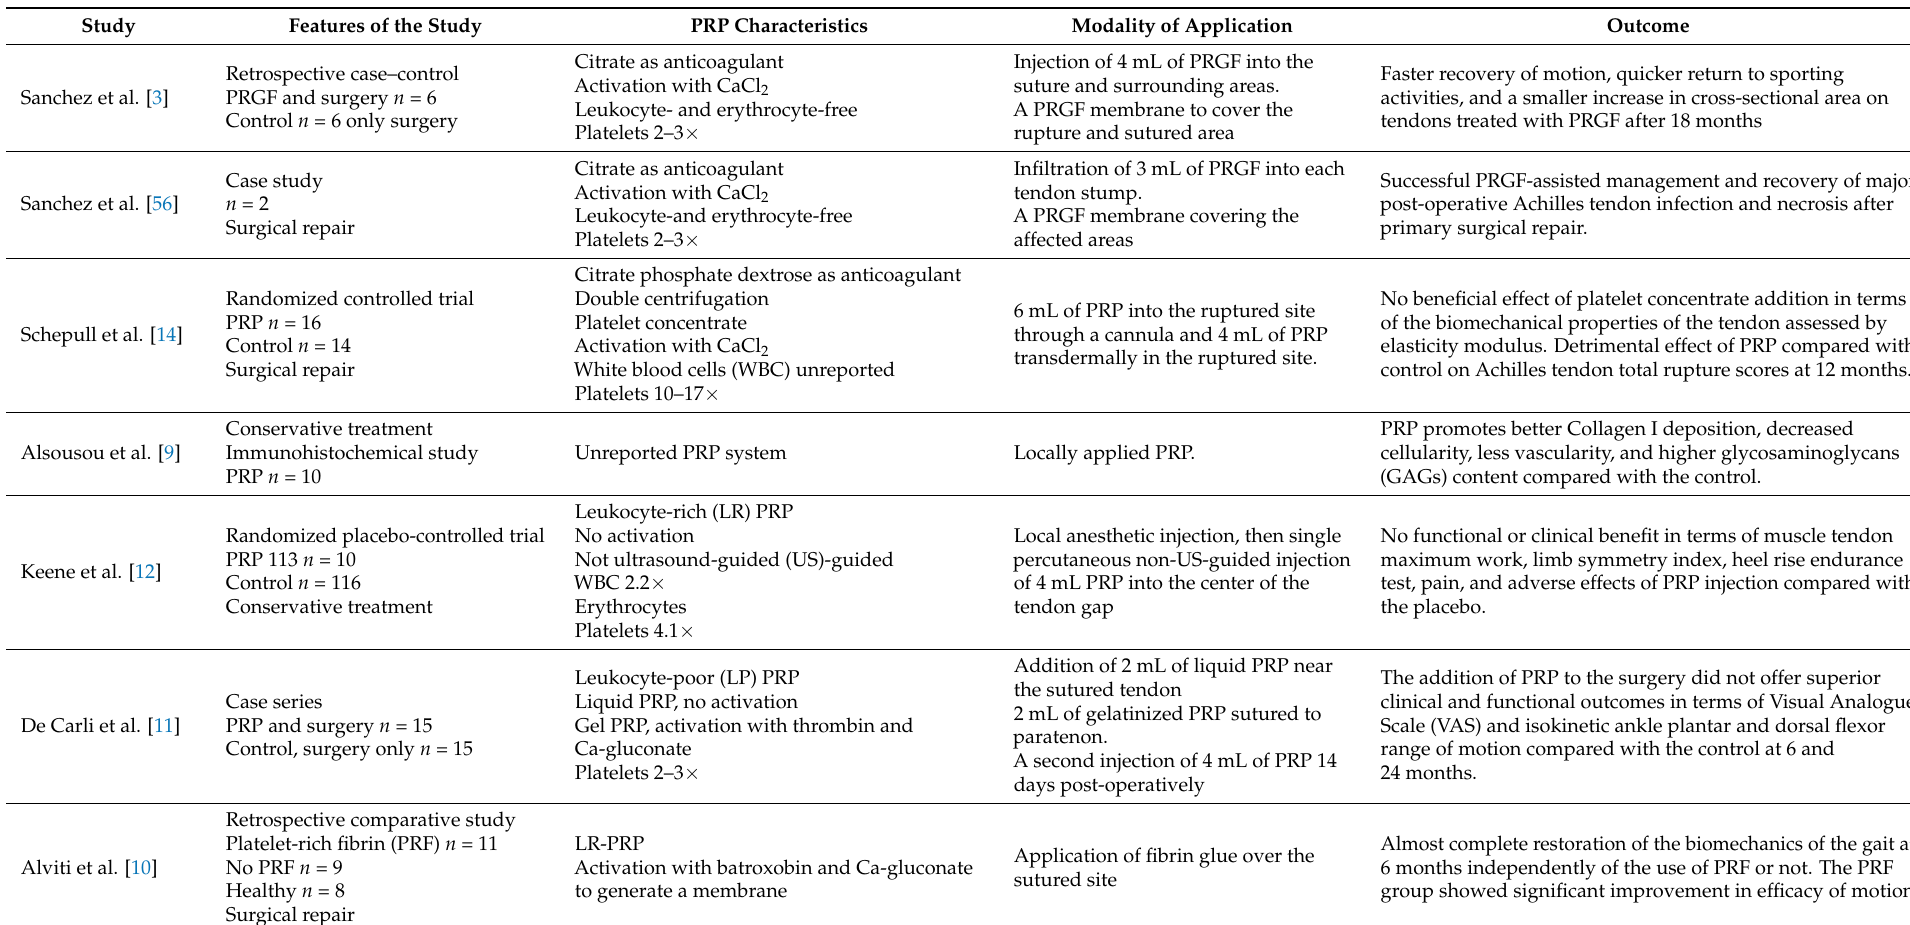
Table 1. Summary of studies on human Achilles tendon rupture treatment assisted with platelet-rich